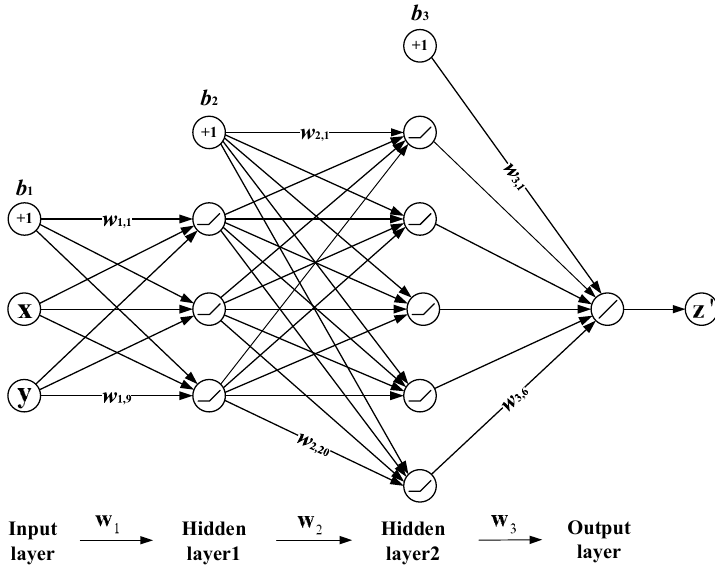
Figure 11. The detailed network structure.